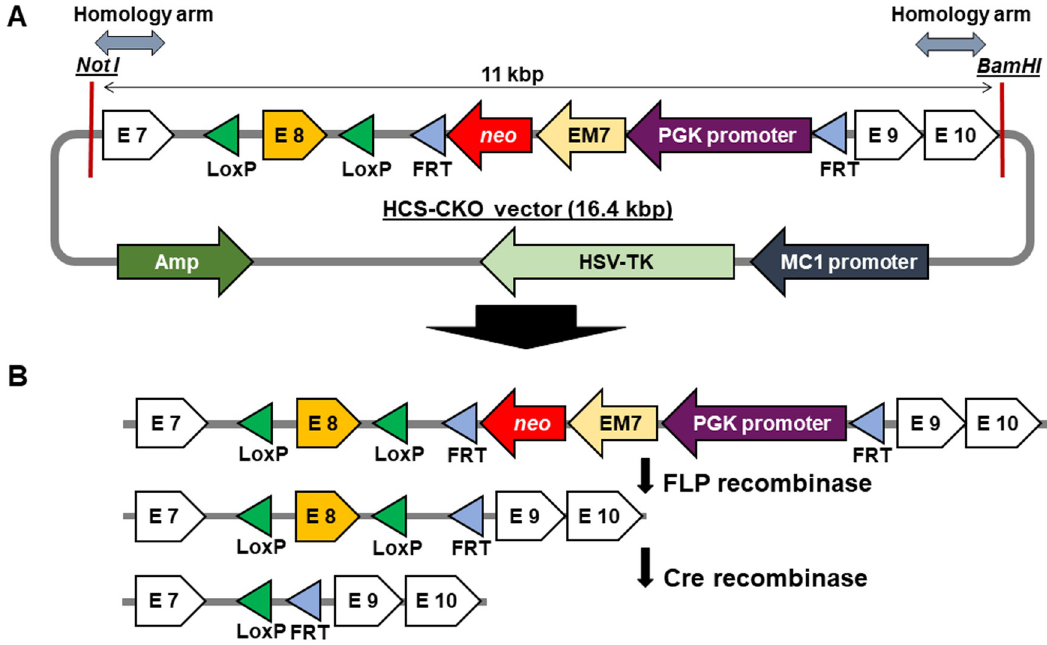
Fig 1. Schematic of the HLCS CKO vector. Amp, ampicillin resistance; E, exon; EM7, prokaryotic promoter; FRT, Flp recognition target; HSV-TK, Herpes simplex virus-1 thymidylate kinase; LoxP, locus of crossover of P1; MC1, target of c-Myc (eukaryotic) promoter; neo , neomycin resistance; PGK, phosphoglycerate kinase (eukaryotic) promoter.